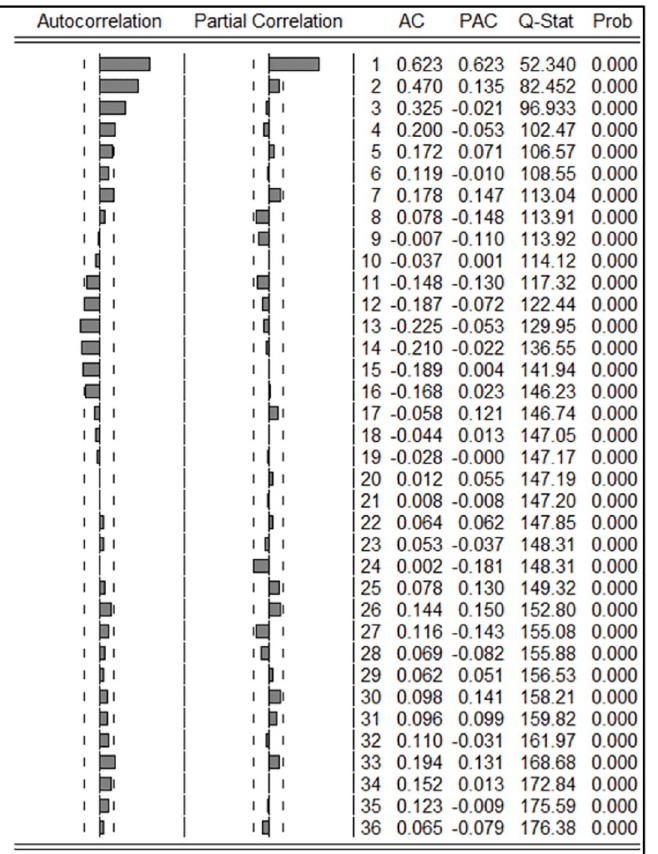
Table 2. Comparison of univariate seasonal ARIMA models for the monthly leptospirosis cases of Anuradhapura District, Sri Lanka. Model